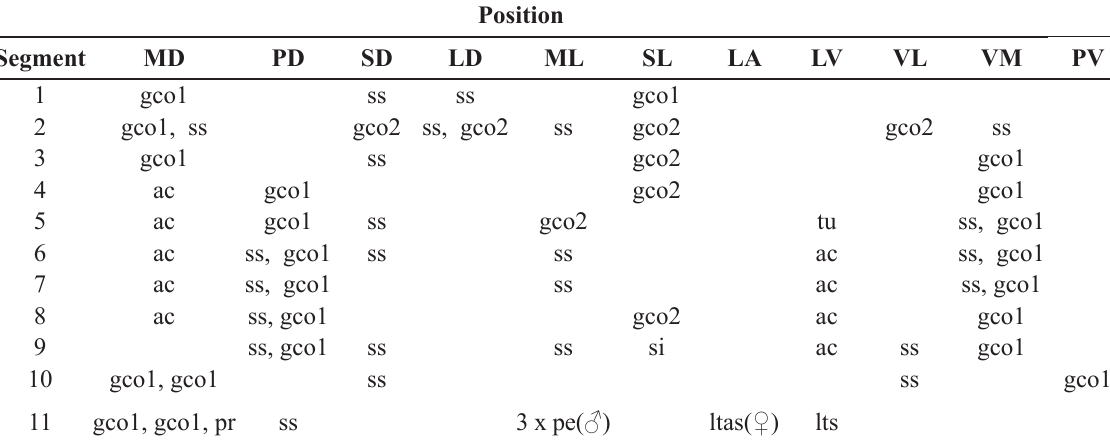
Table 11. Summary of nature and location of sensory spots, glandular cell outlets, tubes and spines arranged by series in Echinoderes juliae sp. nov. Abbreviations: LA = lateral accessory; LD = laterodorsal; LV = lateroventral; MD = middorsal; ML = midlateral; PD = paradorsal; PV = paraventral; SD = subdorsal; SL = sublateral; VL = ventrolateral; VM = ventromedial; ac = acicular spine; gco1/2 = glandular cell outlet type 1/2; ltas = lateral terminal accessory spine; lts = lateral terminal spine; pe = penile spines; pr = protuberance; si = sieve plate; ss = sensory spot; tu = tube; ( ♀) = female and ( ♂ ) = male conditions of sexually dimorphic